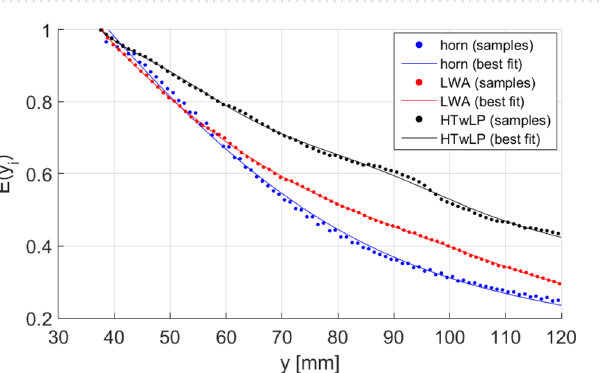
Figure 10. Comparison between horn, LWA, and HTwLP penetrations averaged according to Eq. (14) in a lossy medium for which σ = 0.05 S m , µ r = 1and ε r =